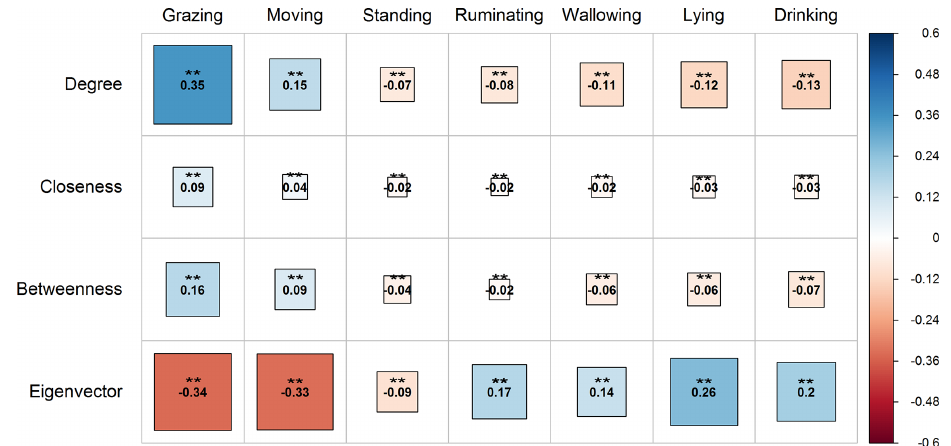
Figure 3. Correlogram presenting the pattern, the strength, and the significance level of Spearman’s rank correlations (two-tailed) between the local indices (degree, closeness, betweenness, and eigenvector) and water buffaloes’ activities on pasture (grazing, moving, standing, ruminating, wallowing, lying, and drinking). Red and blue colors represent negative and positive correlation, respectively. Darker colored and bigger square boxes in the panels correspond to higher strength of correlation. Asterisks ( ∗∗ ) indicate the statistically significant level of association at P < 0 .